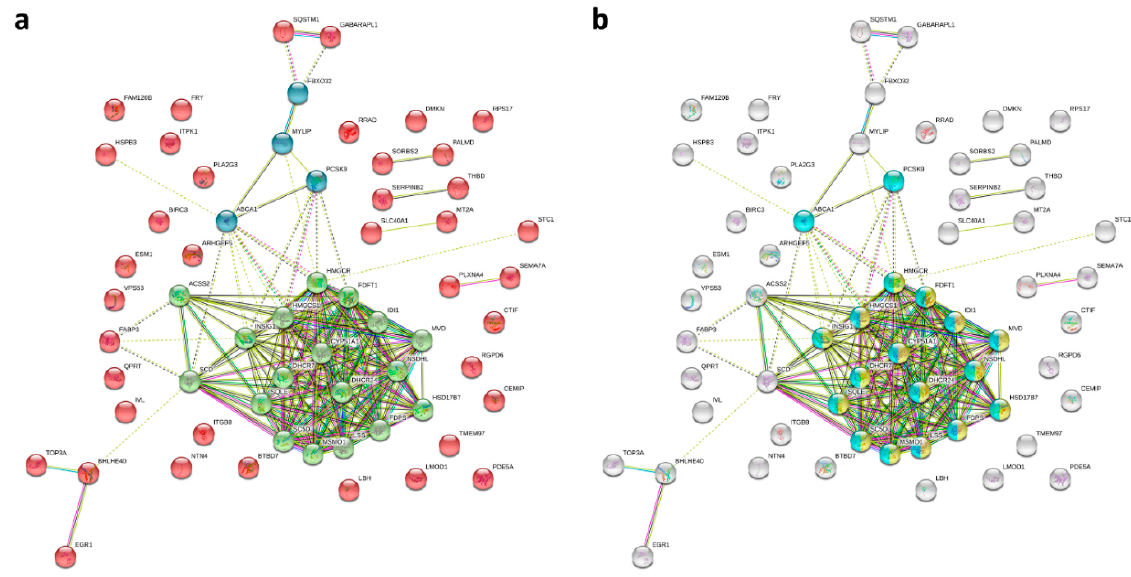
Figure 4. Protein–protein interaction (PPI) network analysis of the differentially expressed genes in idiopathic pulmonary fibrosis (IPF) fibroblasts treated with epigallocatechin gallate (EGCG) versus water using the Search Tool for the Retrieval of Interacting Genes (STRING) database . The 61 differentially expressed genes were input into the STRING database for PPI network analysis, and achieved a PPI network of 61 nodes and 172 edges, with PPI enrichment p -value <1.0 × 10 − 16 . ( a ) Using k-means clustering, the network could be further clustered into three clusters (represented in green, blue, and red colors). ( b ) The genes associated with cholesterol biosynthetic process and cholesterol metabolic process are highlighted with yellow and light blue colors, respectively.